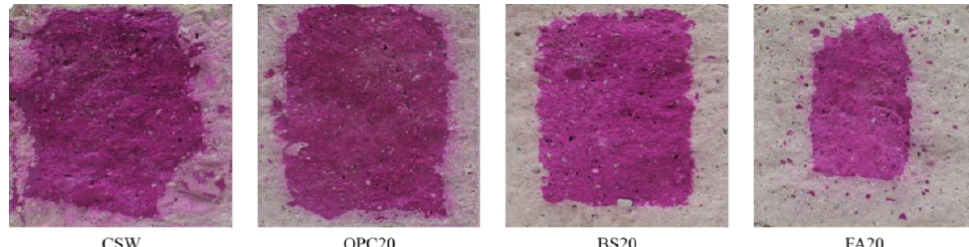
Figure 12. Lean Carbonation specimens.